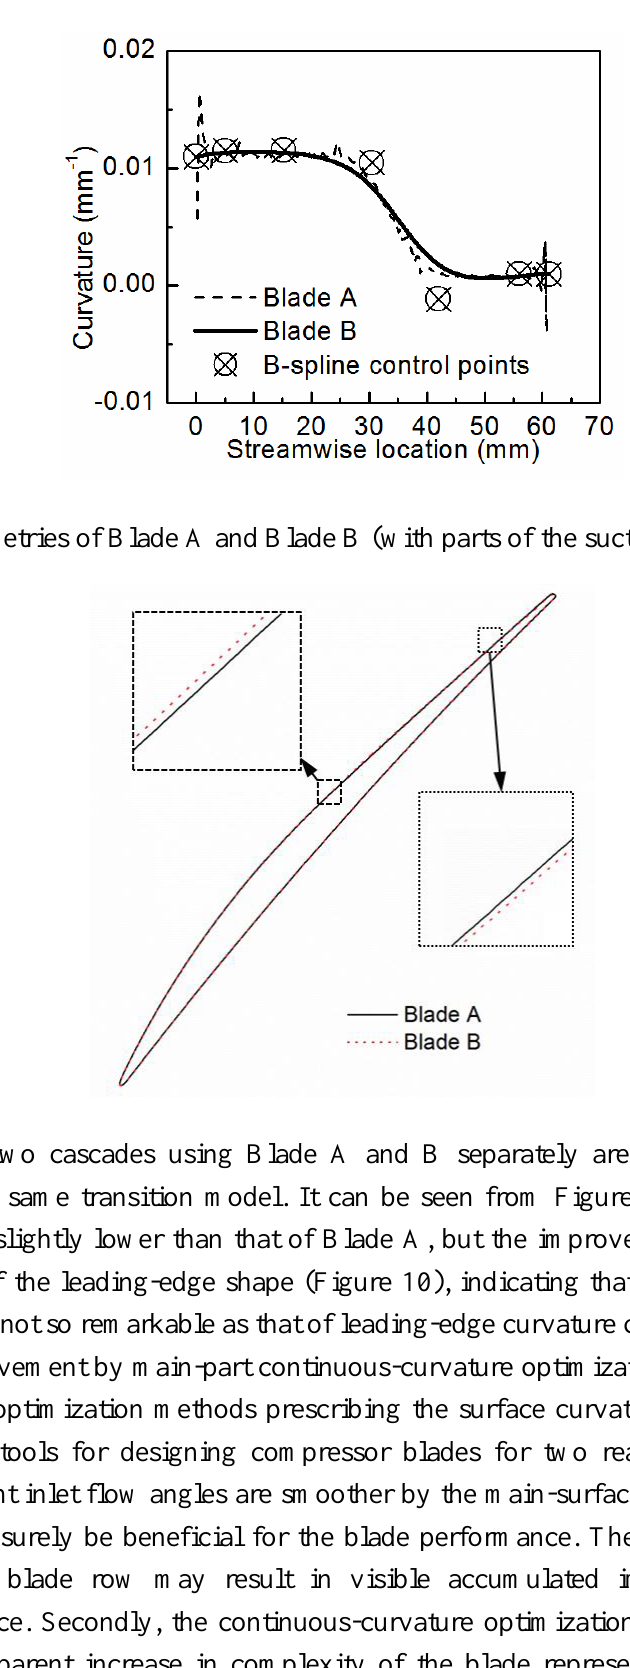
Figure 18. Main-surface curvature distributions of Blade A and B.